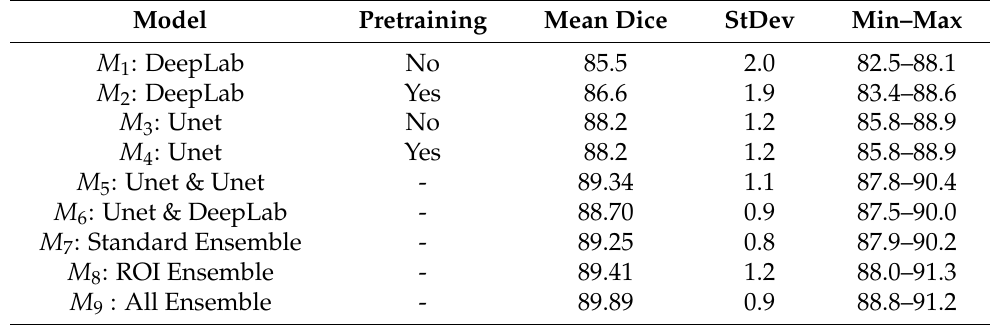
Table 2. Results on the imATFIB validation set (Standard Ensemble: Ensemble of best standard Unet and DeepLab, ROI Ensemble: Ensemble of ROI pipelines ( M 5 and M 6 ), All Ensemble: Ensemble of the previous two ensembles ( M 7 and M 8 ), Ensembling is done by averaging over the predicted softmax values of the models).